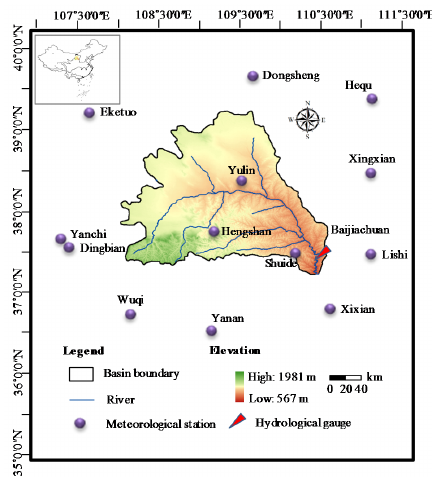
Figure 1. Locations of the study area, hydrological gauge, and meteorological stations.